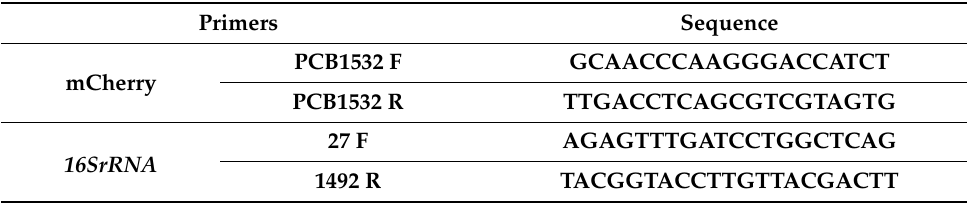
Table 1. List of primers for mCherry and 16SrRNA qPCR and 16SrRNA sequencing. Primers